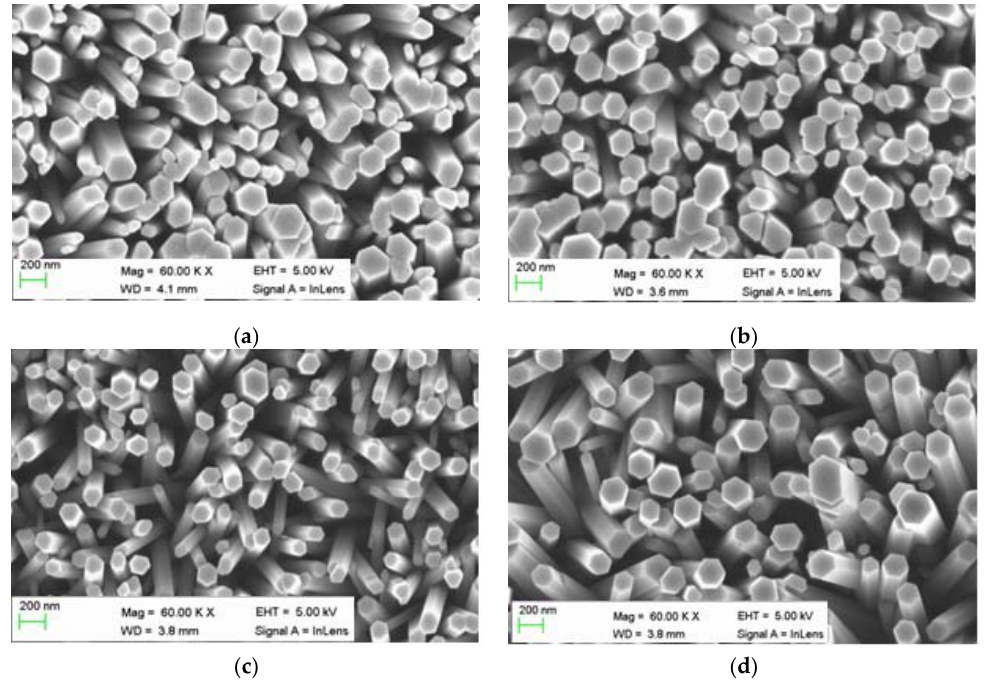
Figure 2. SEM of ( a ) pristine and doped ( b ) with 0.05, ( c ) 0.1, ( d ) 0.15% (w/v) of EG.